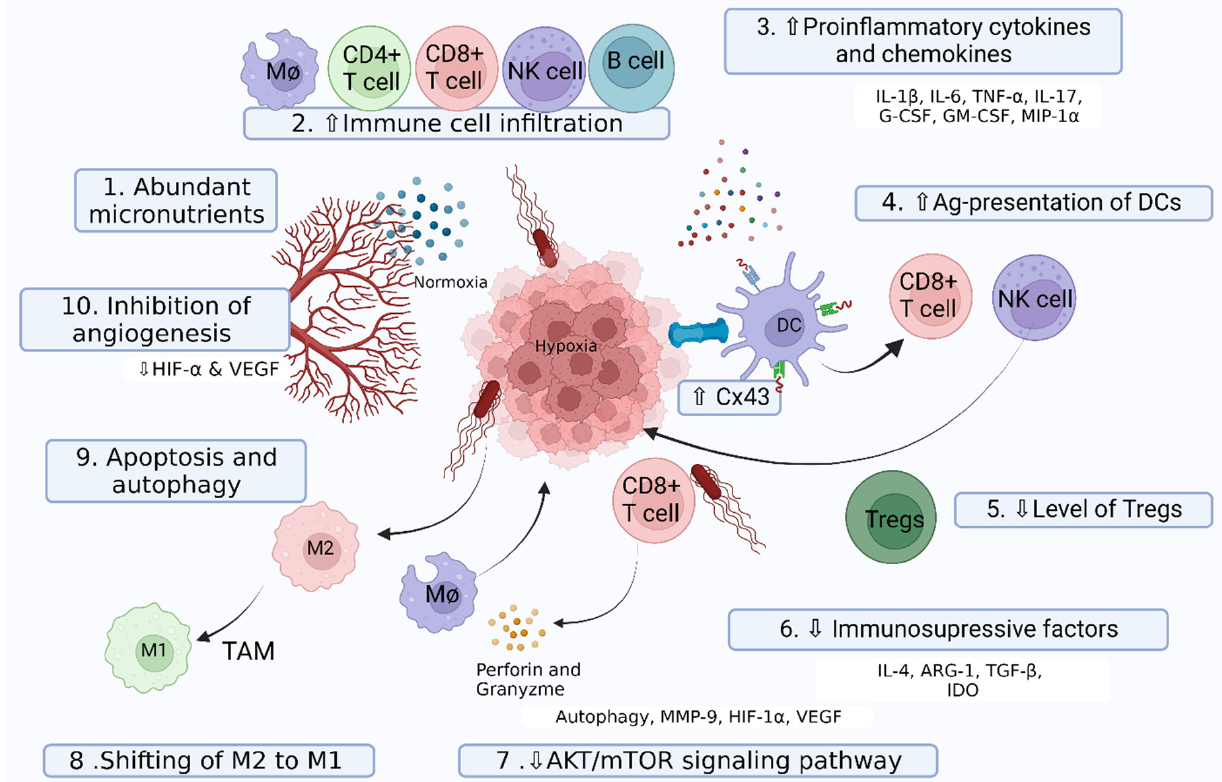
Figure 2. Schematic diagram illustrating the mechanism of Salmonella to manipulate host immune response for tumor inhibition. Transformation of the tumor microenvironment from immunosuppressive to immunogenic occurs through increased infiltration and reprogramming of anti-tumor immune cells, upregulating the expression of proinflammatory cytokines and inducing a shift in the phenotypic and functional characteristics of immune cells. (1) A niche full of micronutrients supports the aggressive growth of Salmonella [87]. (2) Salmonella invasion increases the infiltration of macrophages [88], CD4+ T cells, CD8+ T cells, NK cells [89], and B cells [90] in the tumor microenvironment. (3) Bacterial invasion upregulates the expression of proinflammatory cytokines [91]. (4) Salmonella infection upregulates the Cx43 protein to enhance an antigenic presentation by dendritic cells [92]. (5) Activation of CD8+ T cells and NK cells downregulates Treg cells [93,94]. (6) Downregulation of immunosuppressive factors favors better immune protective response [95,96]. (7) Cytotoxic T cells release perforin to lyse the tumor cells [38,97]. (8) Transition of M2 macrophage to M1 macrophage orchestrates the protective anti-tumor immune response [88,98]. (9) Salmonella induces apoptosis and autophagy through its intrinsic properties [99–101]. (10) Chaotic vasculature is disrupted by inhibition of angiogenesis via downregulation of hypoxia-inducible factor-1 alpha (HIF-1 α ) and vascular endothelial growth factor (VEGF) [38]. All of the steps are summarized in the text. M Φ : macrophage; IL: